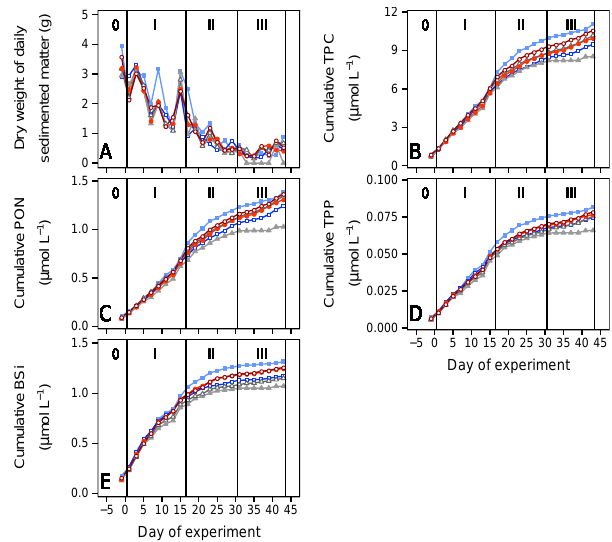
Figure 16. Temporal dynamics in (a) collected sediment trap mate- rial mass and cumulative (b) total particulate carbon, (c) particulate organic nitrogen, (d) total particulate phosphorus, and (e) particu- late biogenic silica. Concentrations in ( b – e ) were calculated based on individual mesocosm volumes determined at the end of the study. Colours and symbols for different treatments are described in Ta- ble